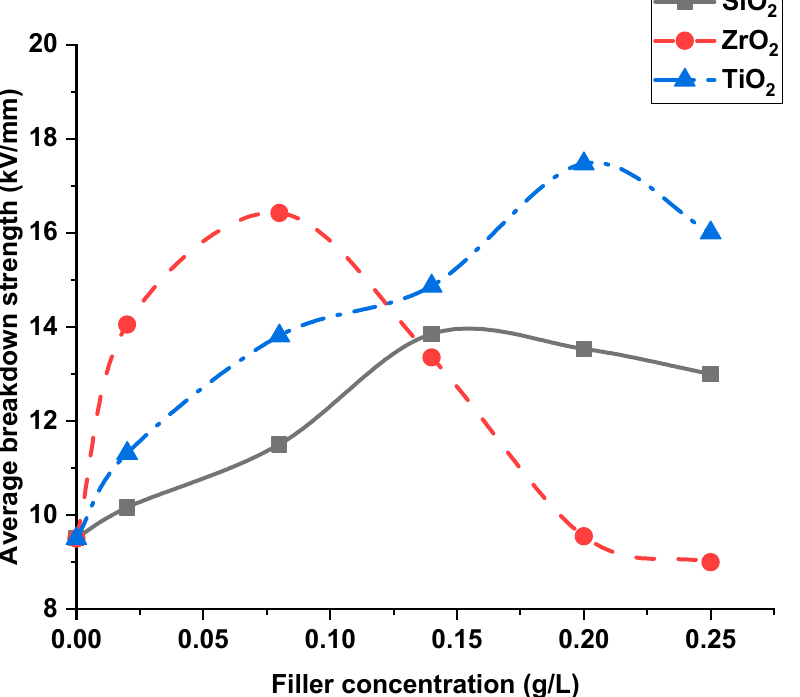
Figure 5. Average breakdown strength of transformer oil.